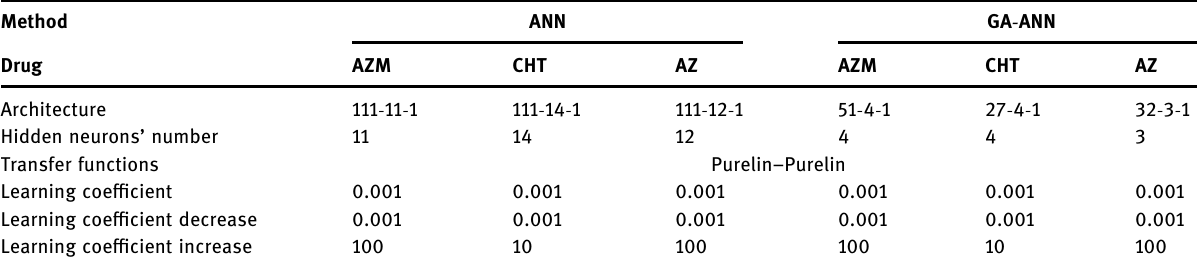
Table 3: Optimized parameters of ANNs